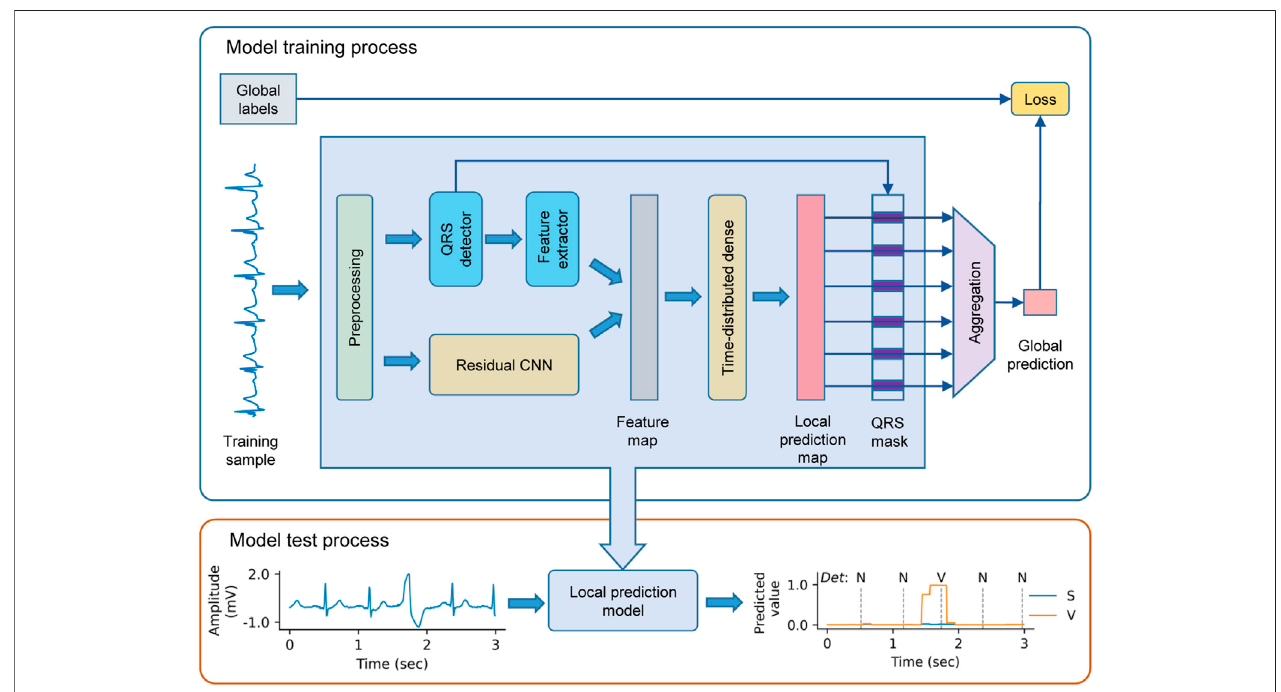
FIGURE 2 | The schematic diagram of the weakly supervised deep learning framework for arrhythmia detection (WSDL-AD). CNN = convolutional neural network. N = normal or bundle branch block beat. S = supraventricular ectopic beat. V = ventricular ectopic